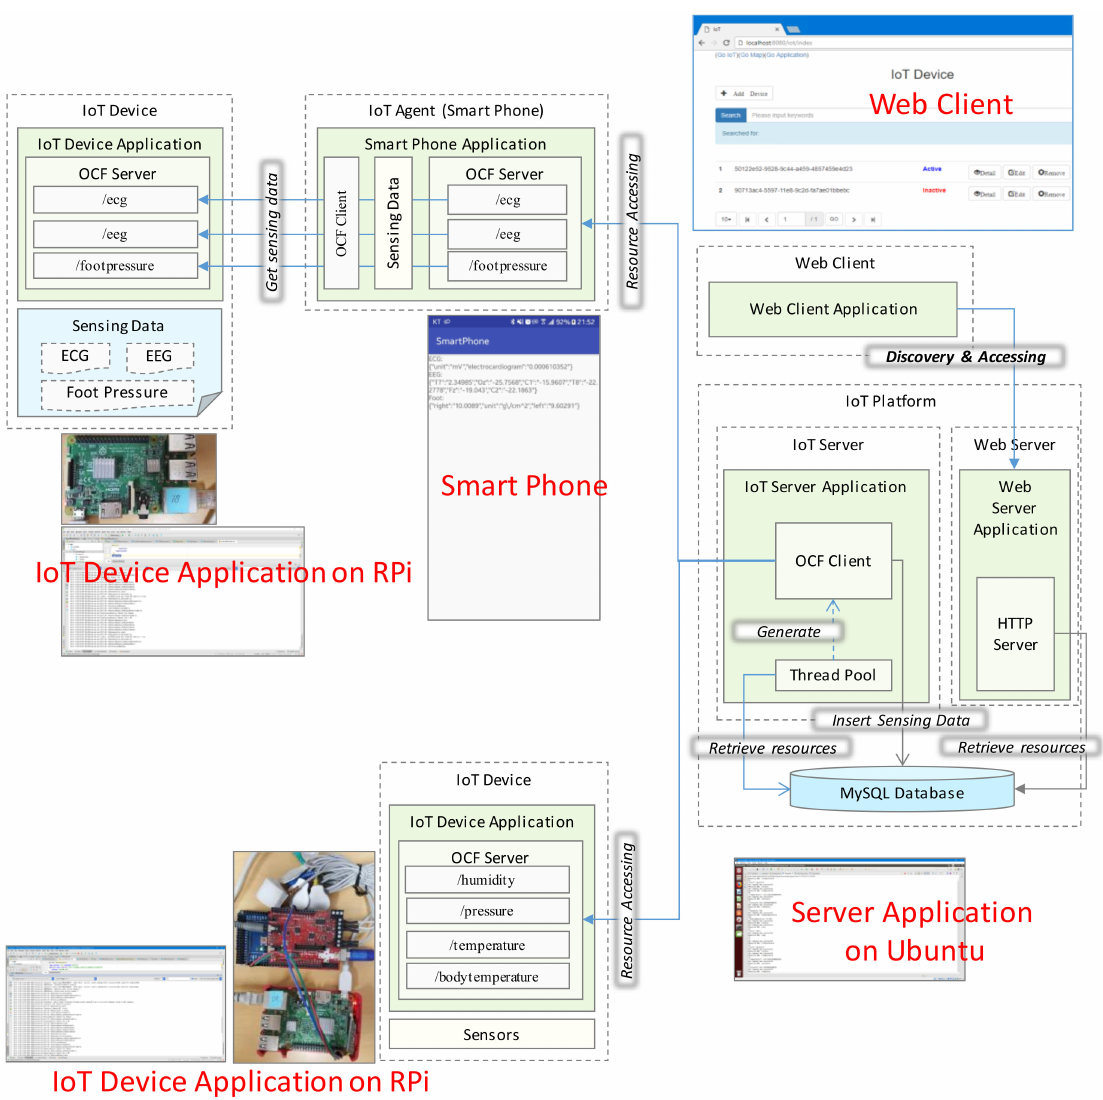
Figure 12. Experiment environment for interactions in the proposed IoT